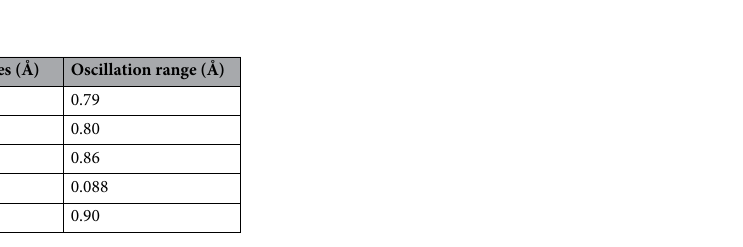
Table 4. Bending Stiffness changes of carbon nanotubes versus chirality of nanotubes.